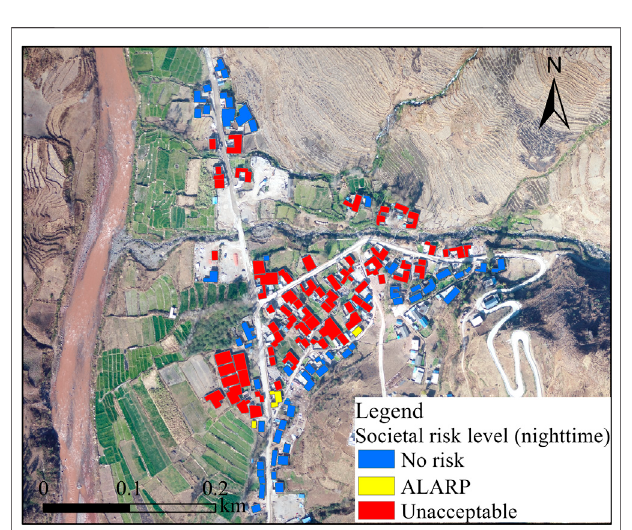
FIGURE 13 | Ratio of the societal risk during the daytime to that at night in Luomo village.